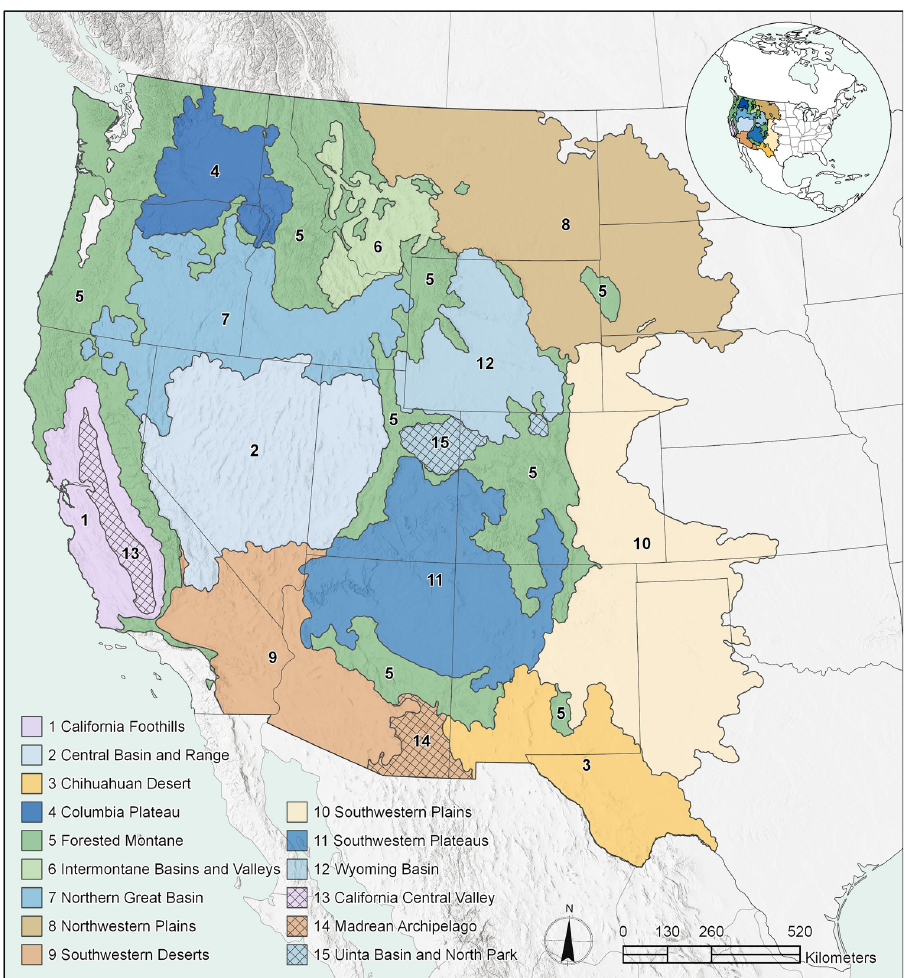
Fig 1. Geographic extent of study area with boundaries of modeling regions (1–12) shown in colored fill and projection regions (13–15) with crosshatch.